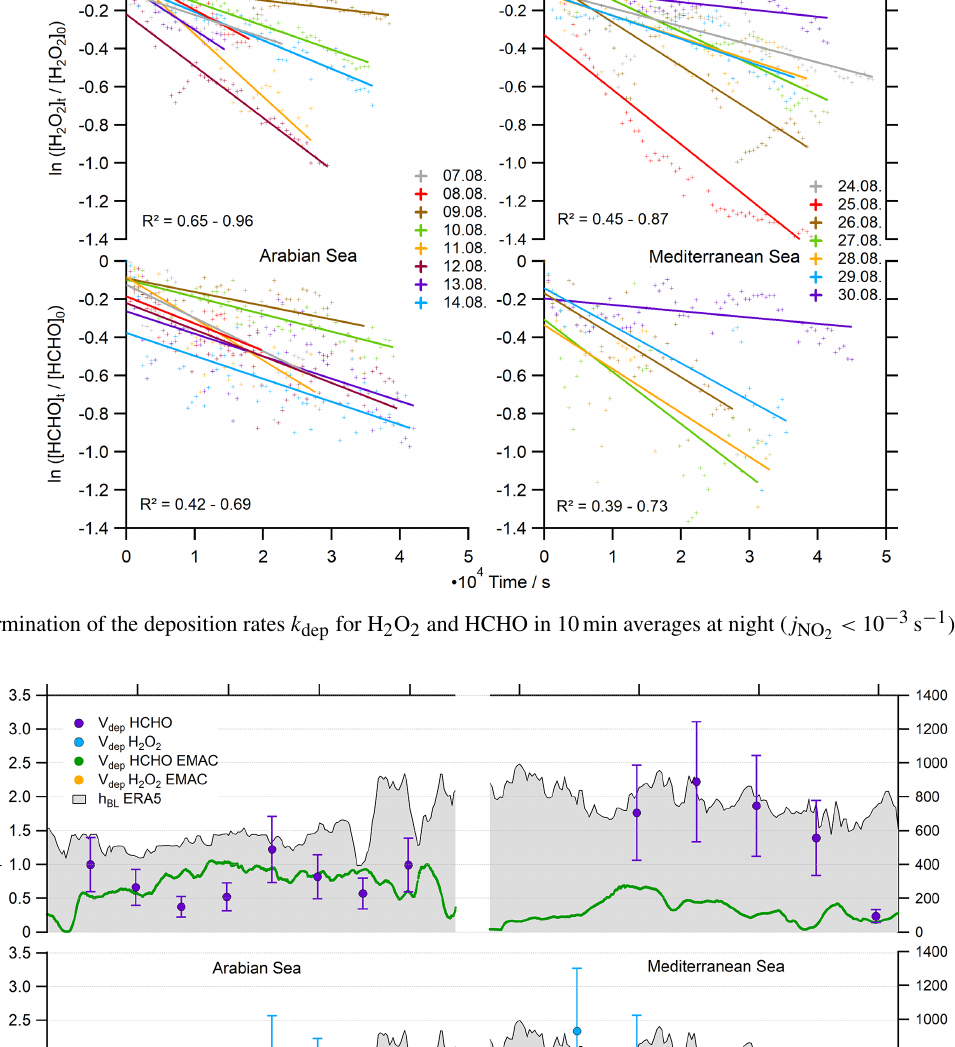
Figure 11. Comparison of the calculated deposition velocity V dep for HCHO and H 2 O 2 in the Arabian Sea (AS) and the Mediterranean Sea